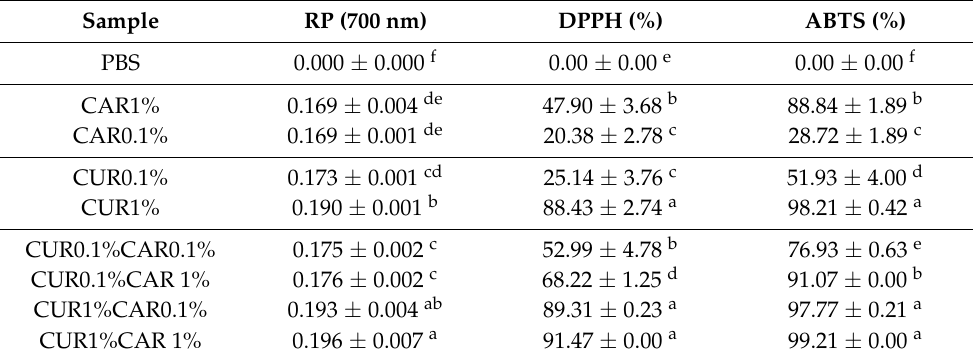
Table 2. Reducing power (RP) and radicals scavenging activity of PBS-based